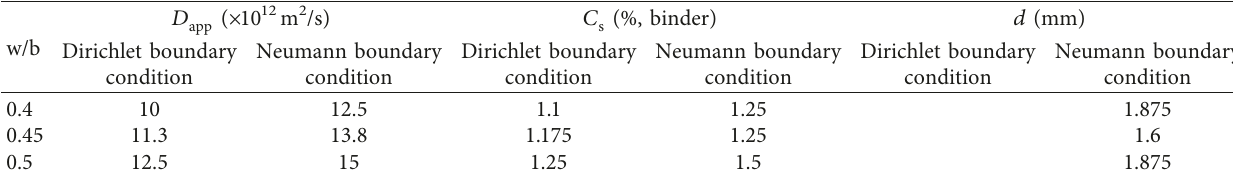
Table 3: Values of D